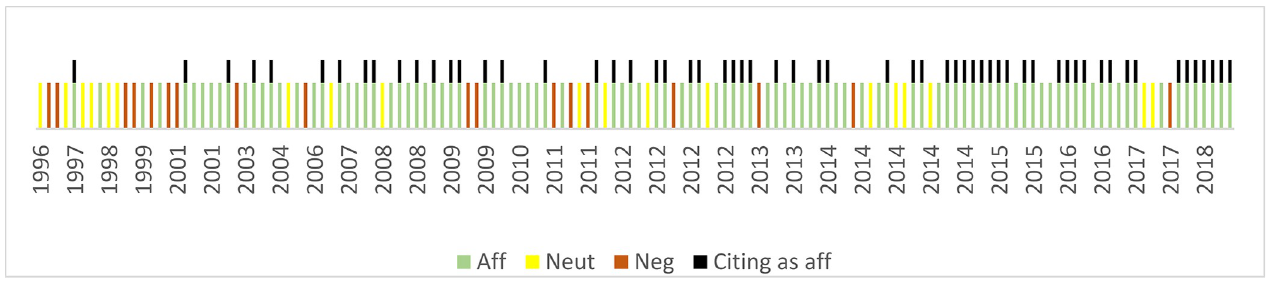
Fig 2. Reception of Jones